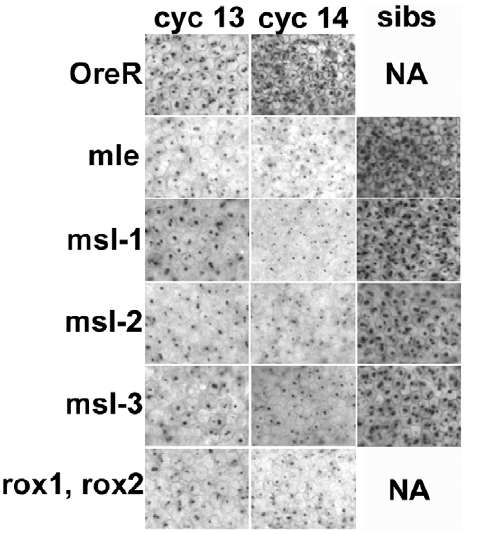
Figure 3. Transcription from the X chromosome dose sensitive promoter of Sxl , Sxl Pe , is reduced in embryos homozygous for the msls . In situs on embryos with an early transcript specific probe reveals two dots/nucleus at the sites of transcription on the X chromosomes during cycles 13 and 14 in development. The roX double mutants had a reduction in expression in most embryos as all the females are mutant, the msls showed reduced expression in about 50% of the embryos (crosses described in text). The ‘sibs’ panels show the signal from normal looking cycle 14 embryos in the same collection, presumably the heterozygous siblings. NA – not applicable. All embryos photographed at 40 6 mag.